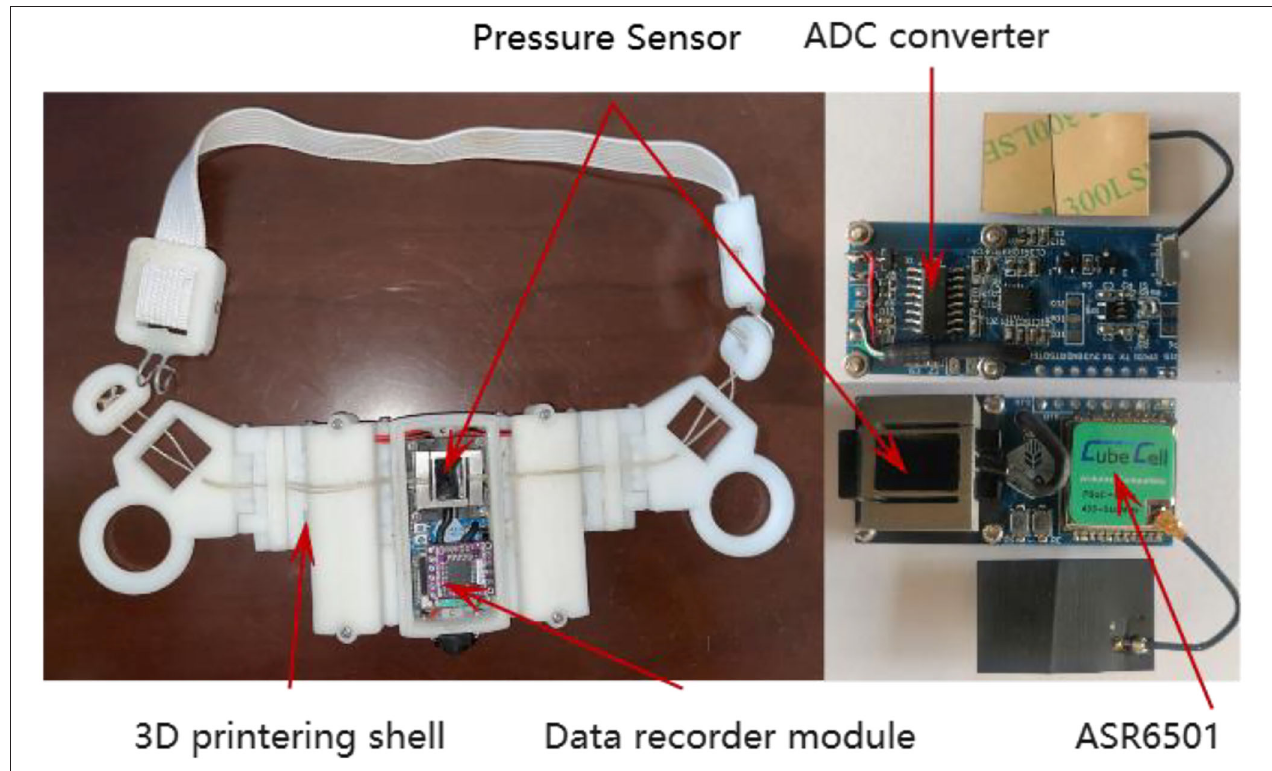
FIGURE 2 | Masticatory pressure collecting device.